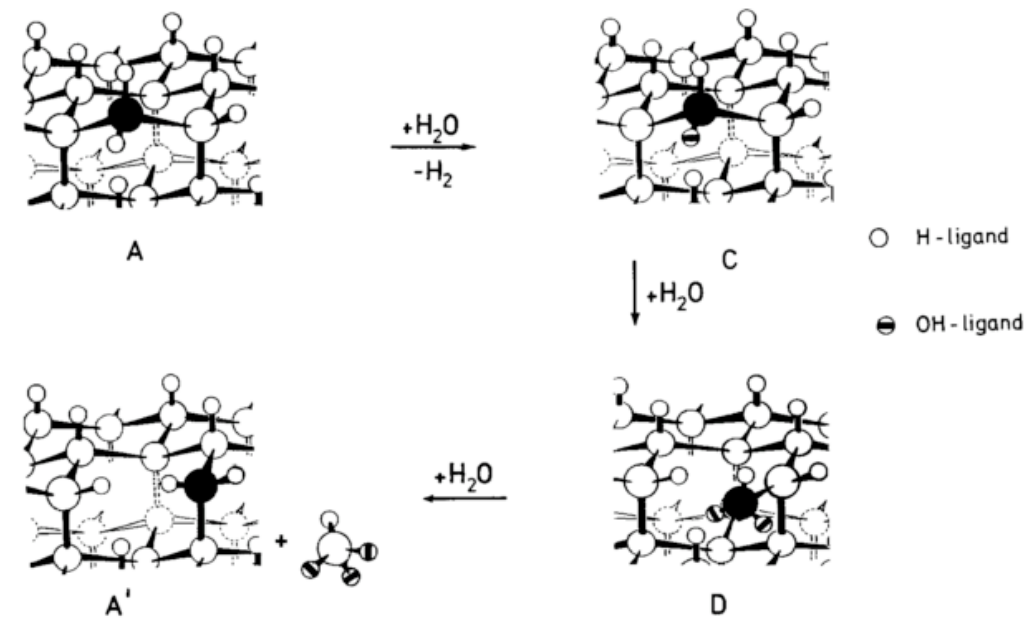
Figure 29. Three-dimensional model for the chemical dissolution of a kink Si atom (black), from the structure A to A’. Reprinted with permission from Reference [95]. Copyright 1993 IOP.